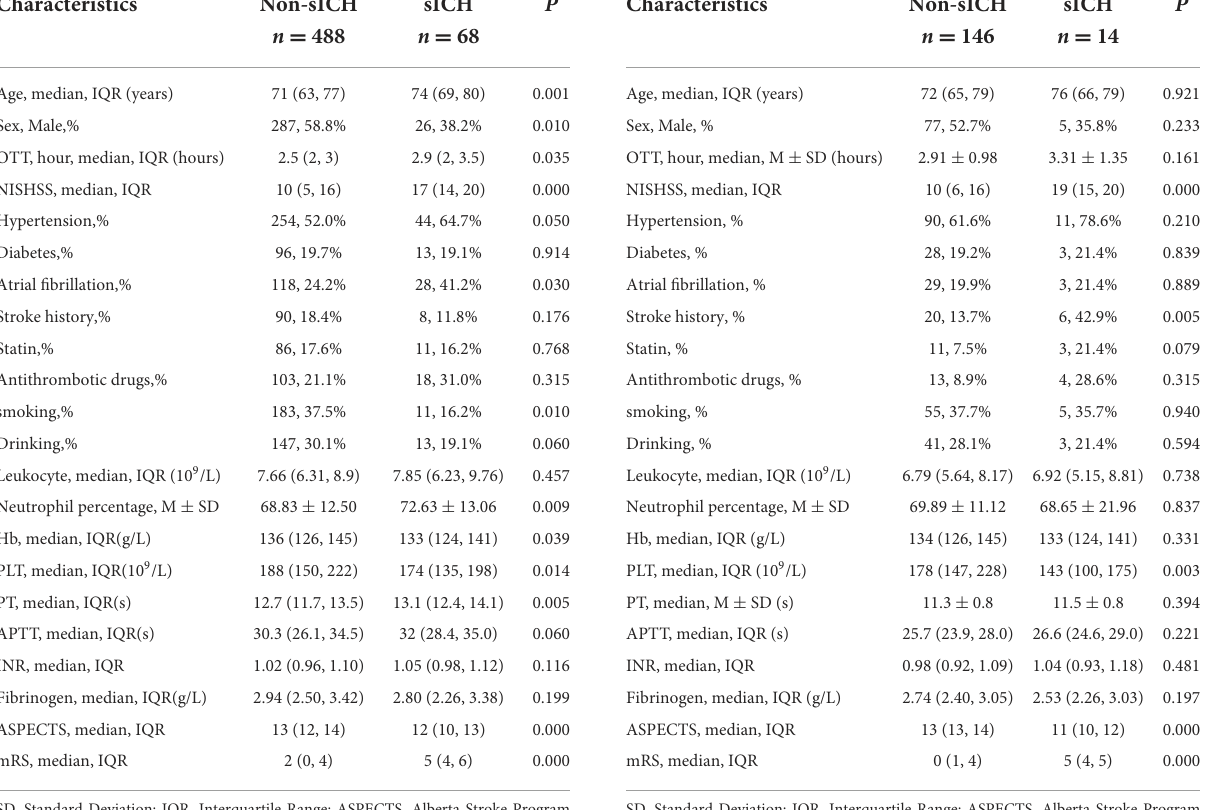
TABLE 1 Demographics and baseline characteristics of patients with and without sICH in the derivation cohort. Characteristics